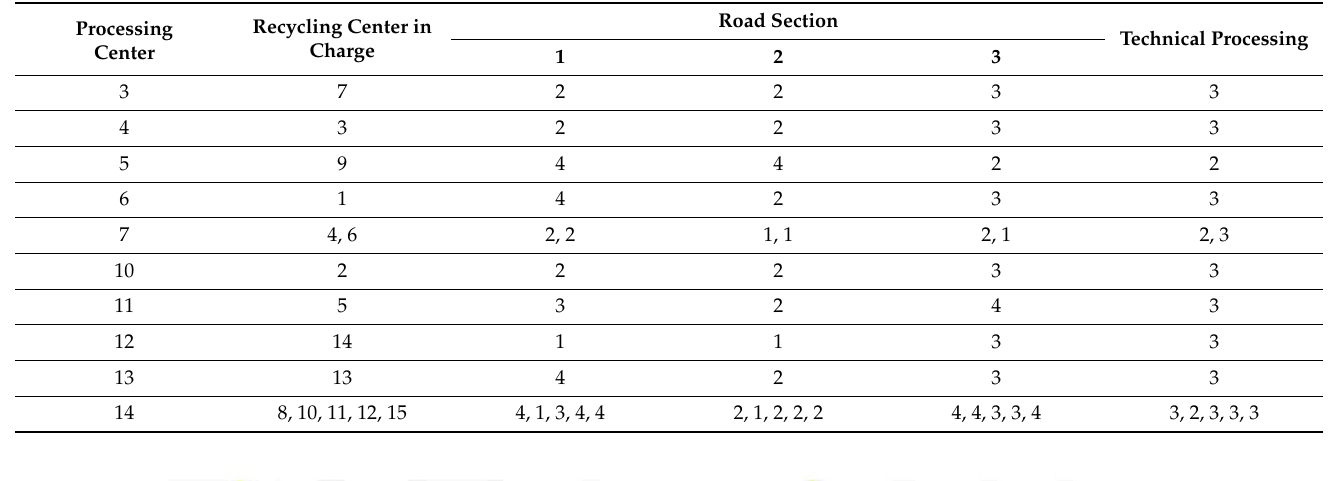
Table 10. Class I sample solution analysis.